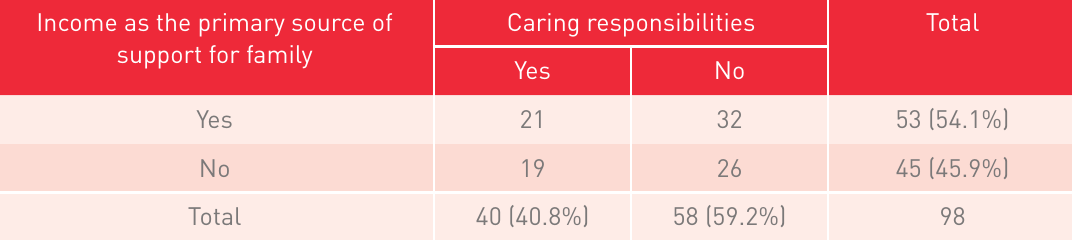
Cross-tabulation of the respondents’ role as primary income earner and caring